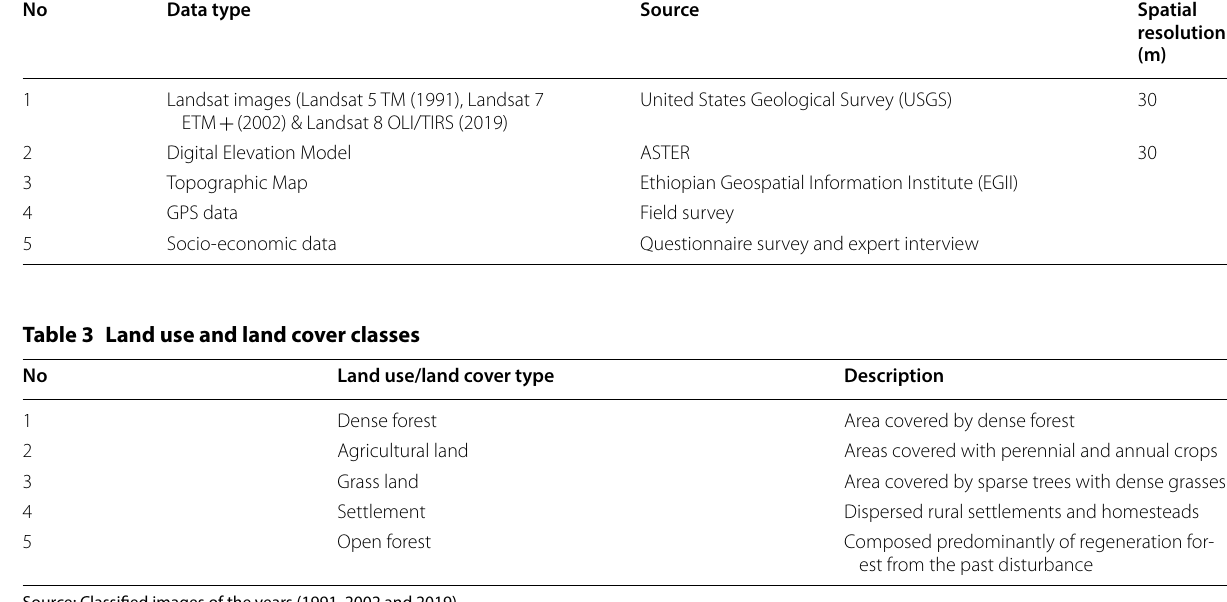
Source: Classified images of the years (1991, 2002 and